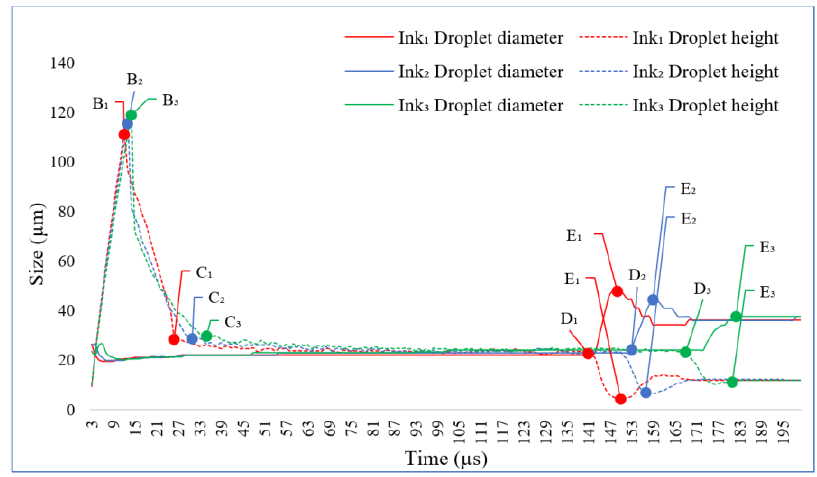
Figure 6. Representation of the droplet size of Ink₁, Ink₂, Ink₃ versus time. If we compare the jets of the different inks regarding length and maximum diameter (horizontal cross section), few main differences can be noticed. Ink₁ with lowest density and viscosity parameters has the smallest jet length and reveals the biggest oscillations. The droplet maximum spreading diameters is E₁ = 47.7 μm. The droplet sphere diameter during flight is ~22 µm. The minimum spreading diameter has Ink₃ which does not oscillate at all. The latter depends on droplet density and viscosity parameters—the droplet takes its final form then it touches the substrate.